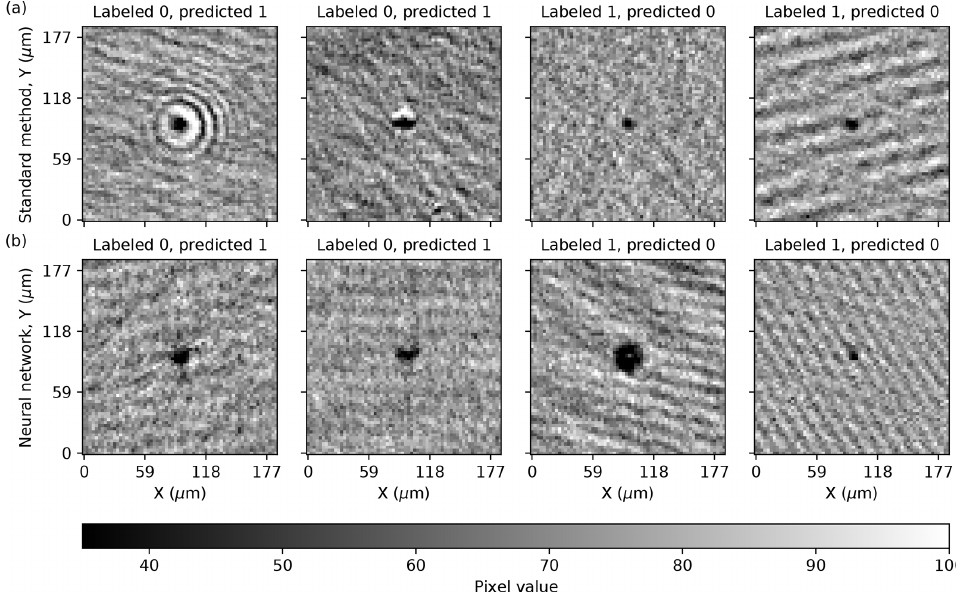
Figure 13. Examples of incorrect (false positive) or missed predictions (false negative) made by (a) the standard method and (b) the neural network model N SH = 1000. The title in each panel shows the manual label and that determined by the model. False negatives are indicated by “labeled 0” and false positives are indicated by “predicted 1”. The pixel values ranged from 0 to 255 in each